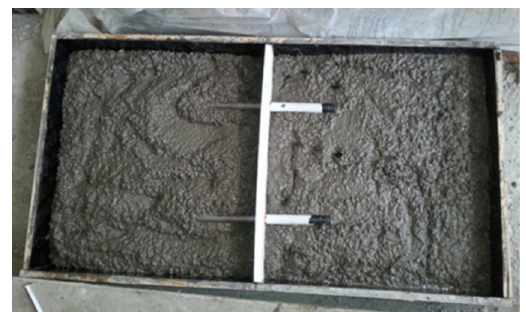
Fig. 1. The Cork Piece is used to Represent the Joint.